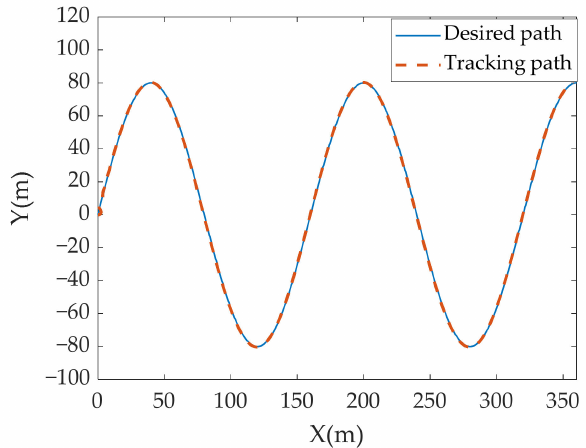
Figure 10. Tracking for sine path.